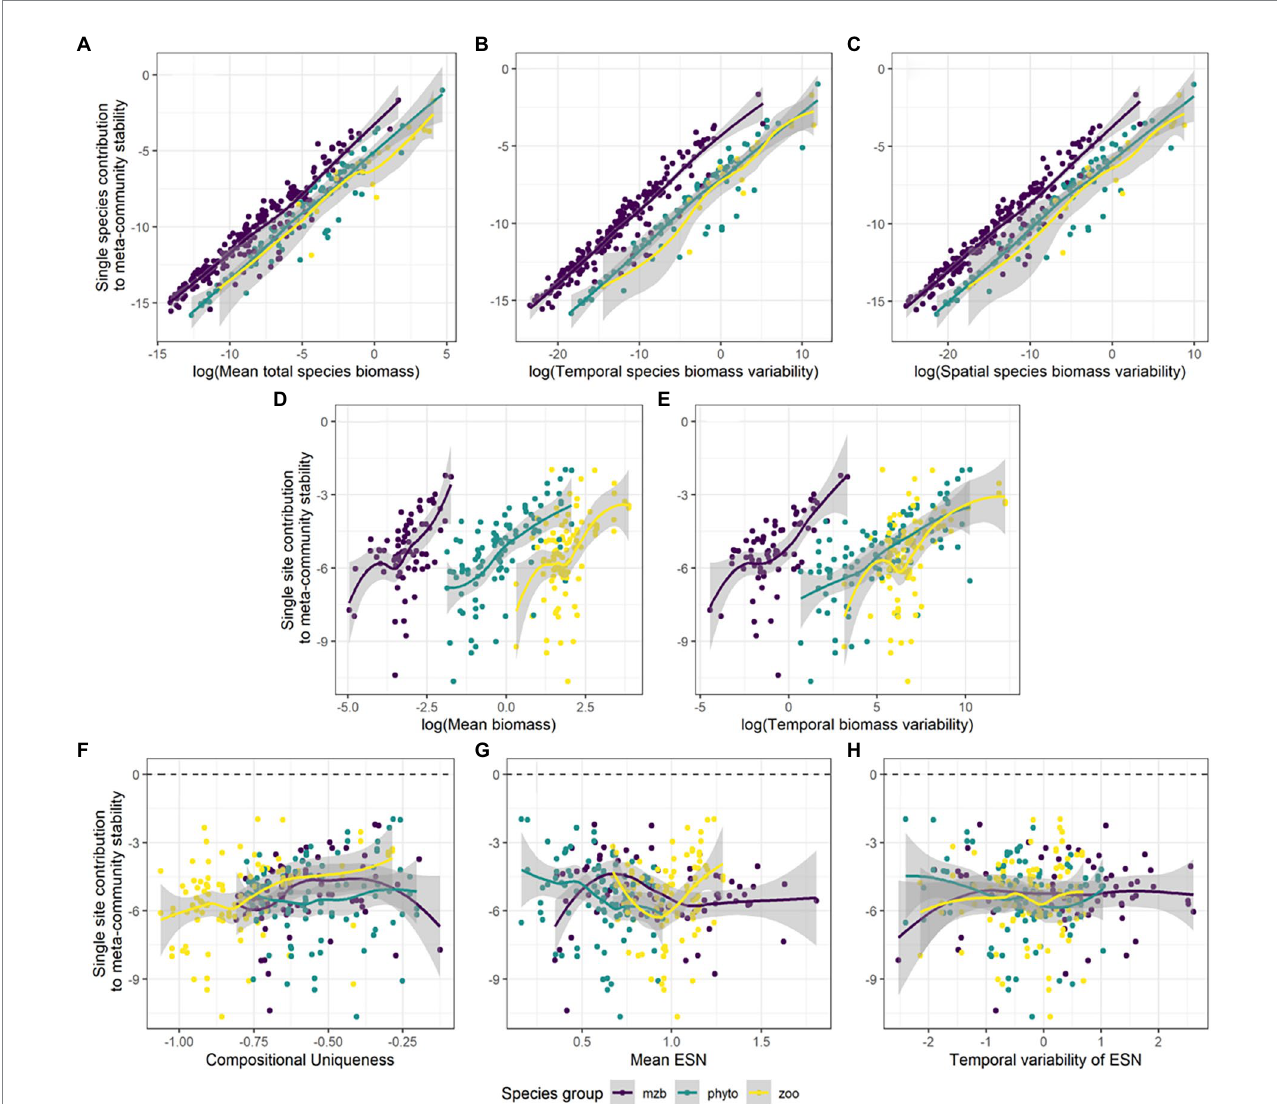
FIGURE 6 Absolute species and site contributions to the spatial scaling of the temporal stability of meta-community biomass. Species contributions are correlated against their (A) mean total biomasses, (B) temporal biomass variability, and (C) spatial biomass variability. Site contributions are shown in relation to their (D) total biomass, (E) temporal biomass variability, (F) compositional uniqueness, (G) mean effective number of species (ENS) over time, and (H) temporal variability in ENS. The different colors represent the phytoplankton (green), zooplankton (yellow), and macrozoobenthos (purple) monitoring data